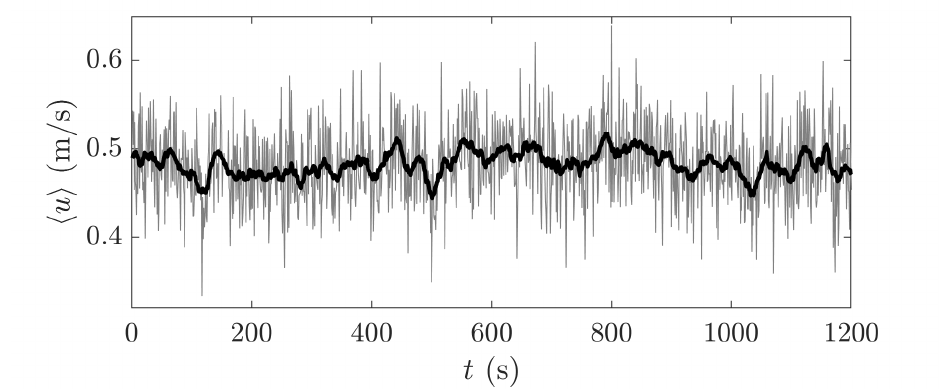
Figure 3. Velocity time seriesfor test T2 at d /2 above the crests of the initial bed averaged in space over the length of the PIV